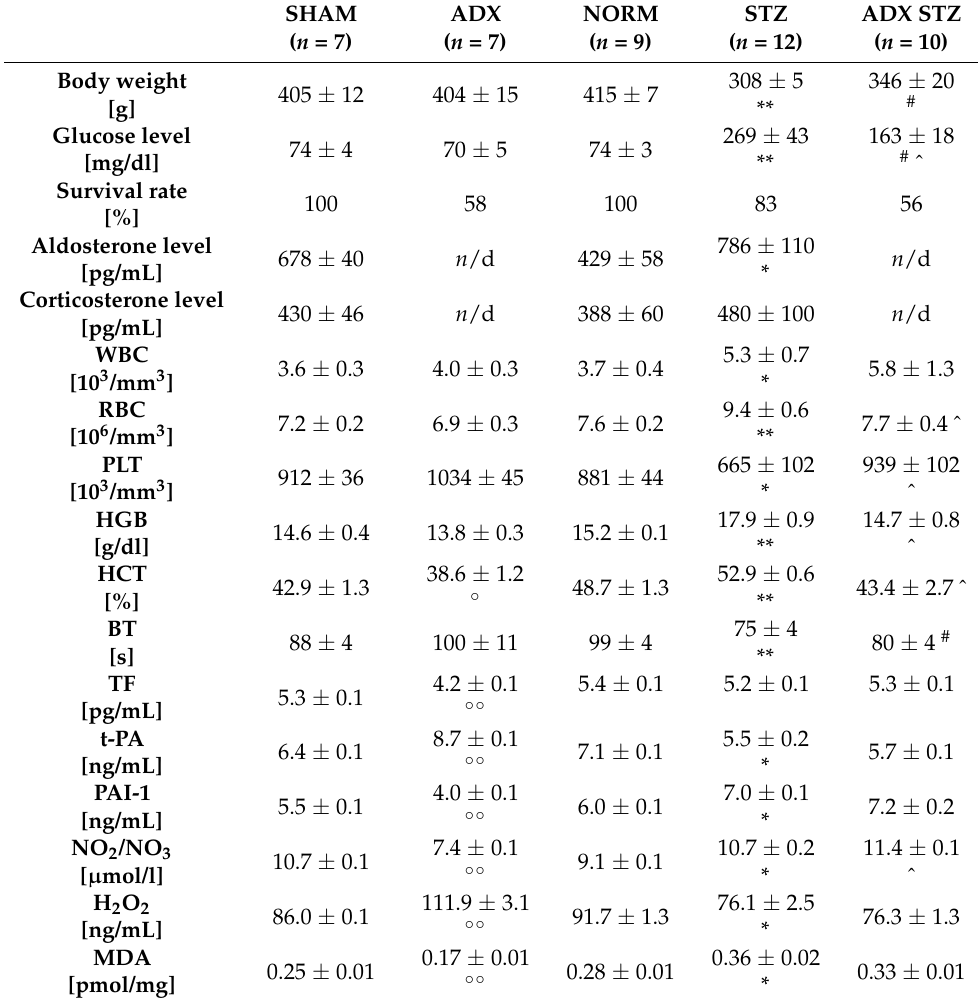
Table 1. General characteristic of sham-operated, adrenalectomized, normoglycemic, and diabetic